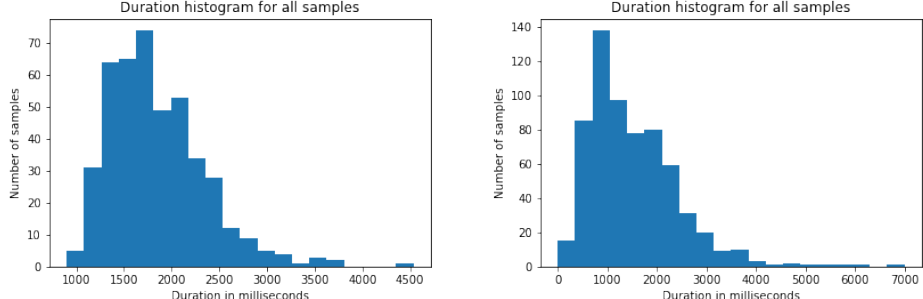
Figure 5. Duration of annotated segments in BUHMAP ( left ) and LSE_GFE ( right